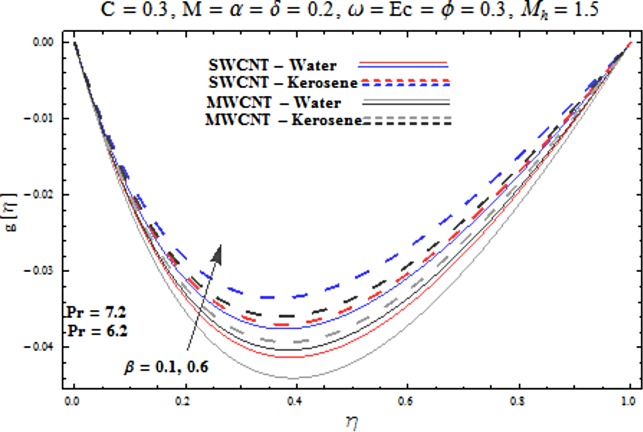
Effect of β on g′.